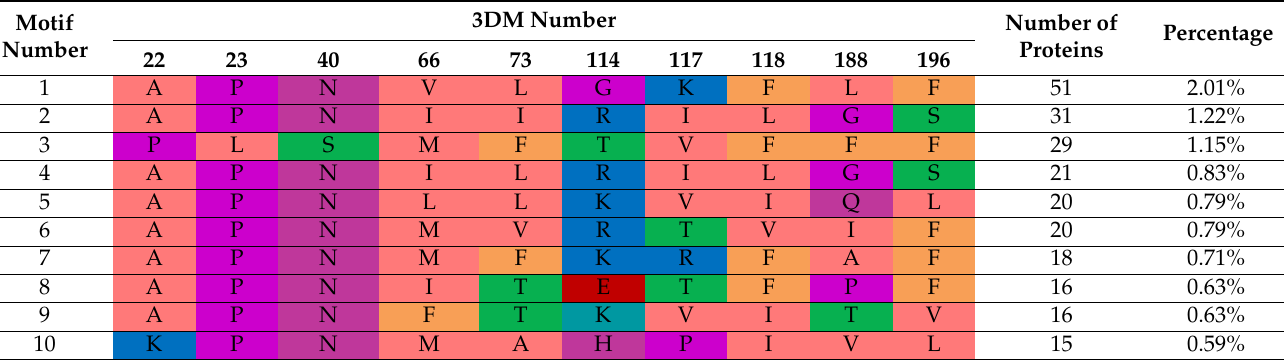
Table 1. Motif overview of correlated mutations of all 376 putative long UPO candidate protein sequences with the catalytic residues PCP, EGD, R and E. Amino acids are coloured in accordance with their physicochemical properties following the Zappo colour